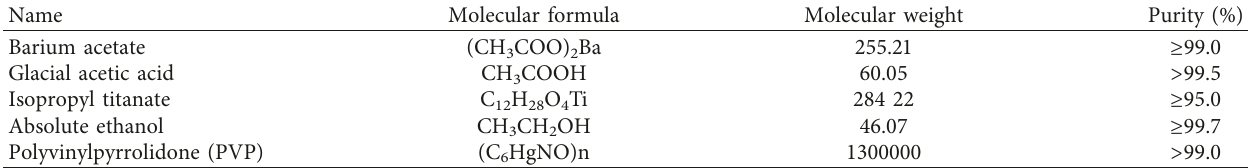
Table 1: List of drugs needed in the preparation of BaTiO